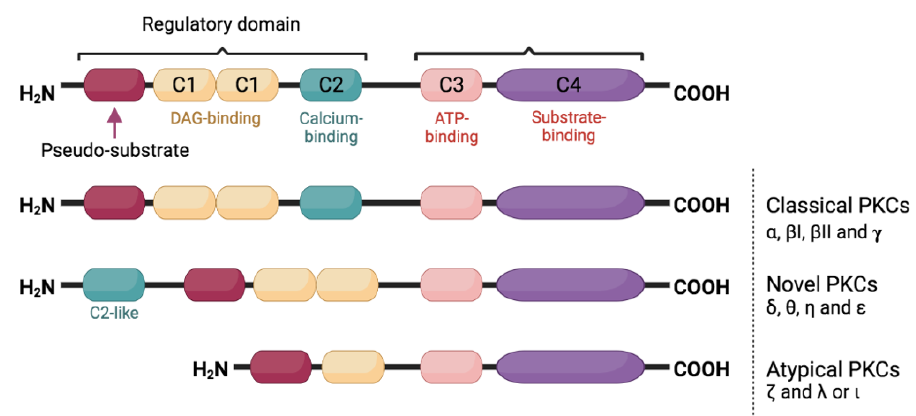
Figure 1. Classification and structural characteristics of PKC isoforms. Although the catalytic domain of PKC is conserved, the three subgroups have different regulatory domains. The classical PKC isoforms (cPKC) share all typical regulatory features: the autoinhibitory pseudosubstrate motif, two DAG-binding C1 domains and the calcium-binding C2 domain. Novel PKC isoforms (nPKC) lack a calcium-binding motif but contain an extended N-terminal domain that can receive regulatory signals, and they are still being regulated by DAG. On the other hand, the catalytic activity of atypical PKC isoforms (aPKC) is independent of DAG and calcium.